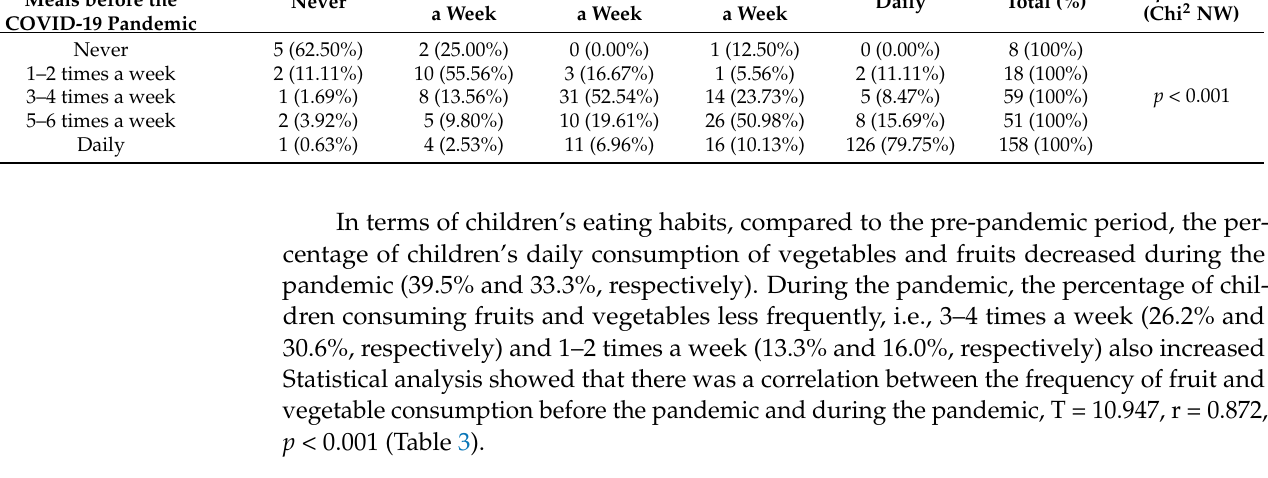
Table 3. The frequency level of fruit and vegetable consumption before and during the COVID-19